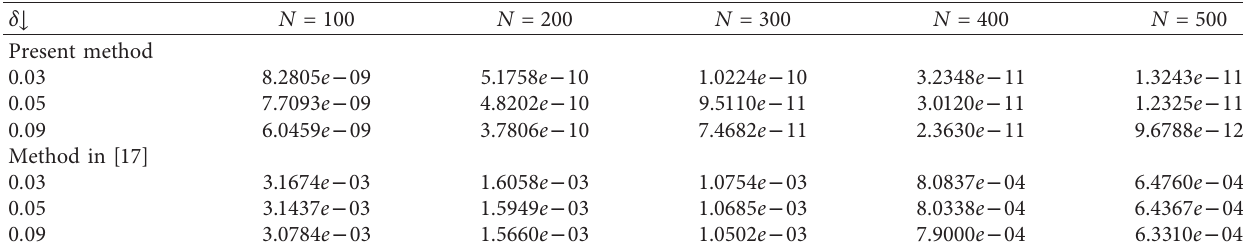
Table 3: The maximum absolute errors of Example 2 for different values of δ with ε � 0 . 1 .